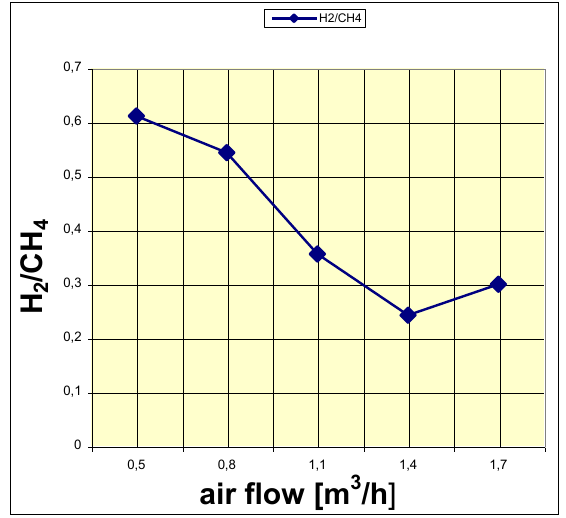
Fig. 6. Characteristics of the methanation process-the degree of